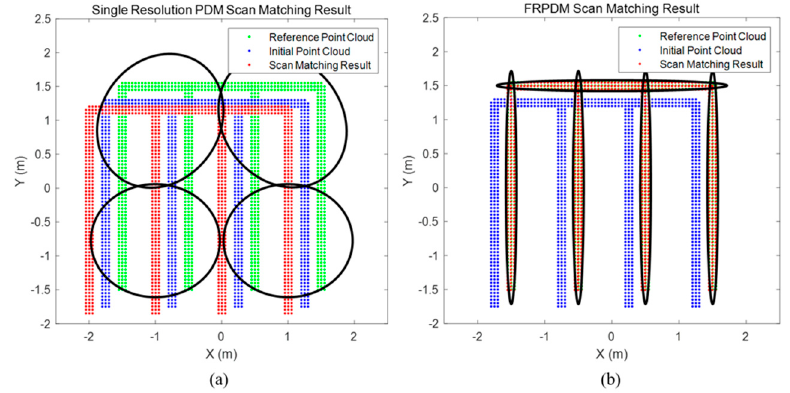
Figure 23. Result of Point-to-Probability Distribution Scan Matching: ( a ) Single resolution PDM (2 m), ( b ) FRPDM.